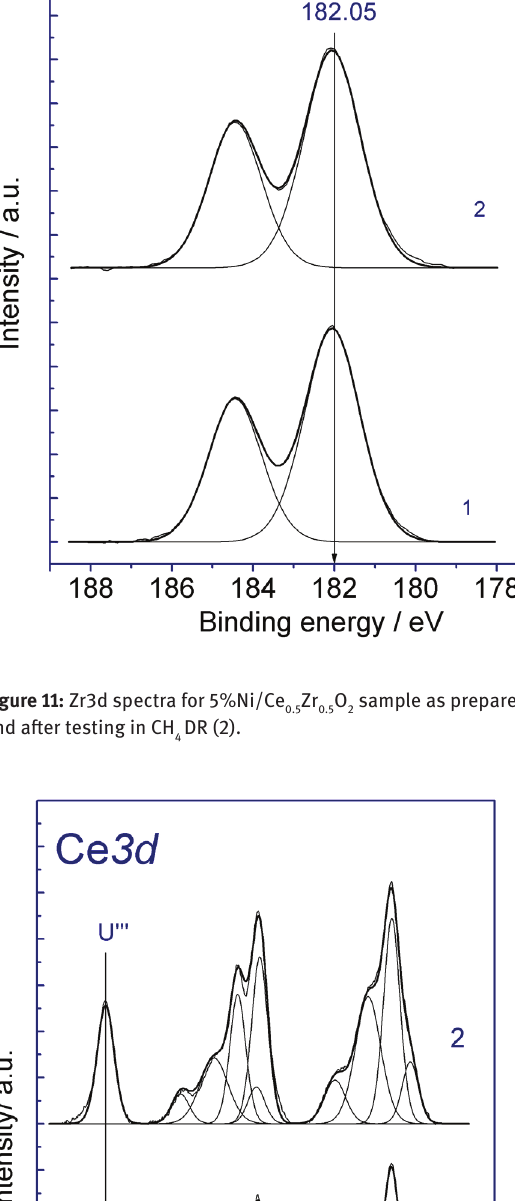
Figure 12: Ce 3d spectra for 5%Ni/ Ce and after testing in CH